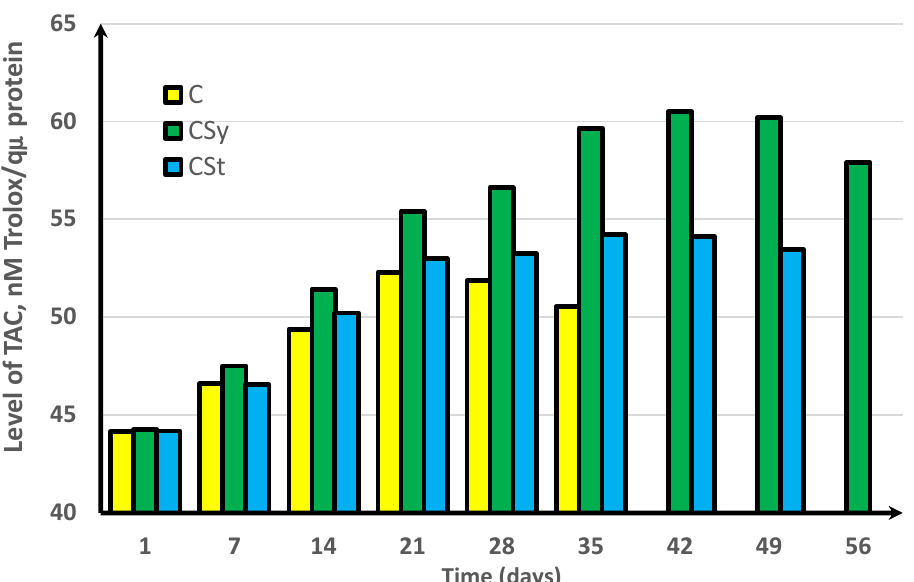
Figure 5. Levels of total antioxidant capacity (TAC) in workers’ hemolymph along with the aging processes, after using two methods of supplementation with hemp extract. C, control (pure sugar syrup); CSy, hemp extract in syrup; CSt, hemp extract on strips (two-way ANOVA: supplementation method: F (5,1078) = 50,034, p = 0.0000, se ± 0.011082 (CSy), se ± 0.012565 (CSt), and se ± 0.013572 (C); days of supplementation: F (5,1078) = 50,034, p = 0.0000, se ± 0.019194 (1st–35th days), se ± 0.033245 (42nd day and 56th day), and se ± 0.023508 (49th day); supplementation method × days of supple- mentation: F (11,1078) = 2952.4, p = 0.0000, and se ± 0.033245). The chart shows statistical averages. The standard deviations for the means in this plot ranged from 0.10133 to 0.35040.